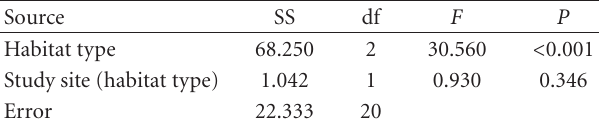
Table 3: Overall nested ANOVA of the e ff ect of habitat type and study site on richness of ant communities ( n = 24).